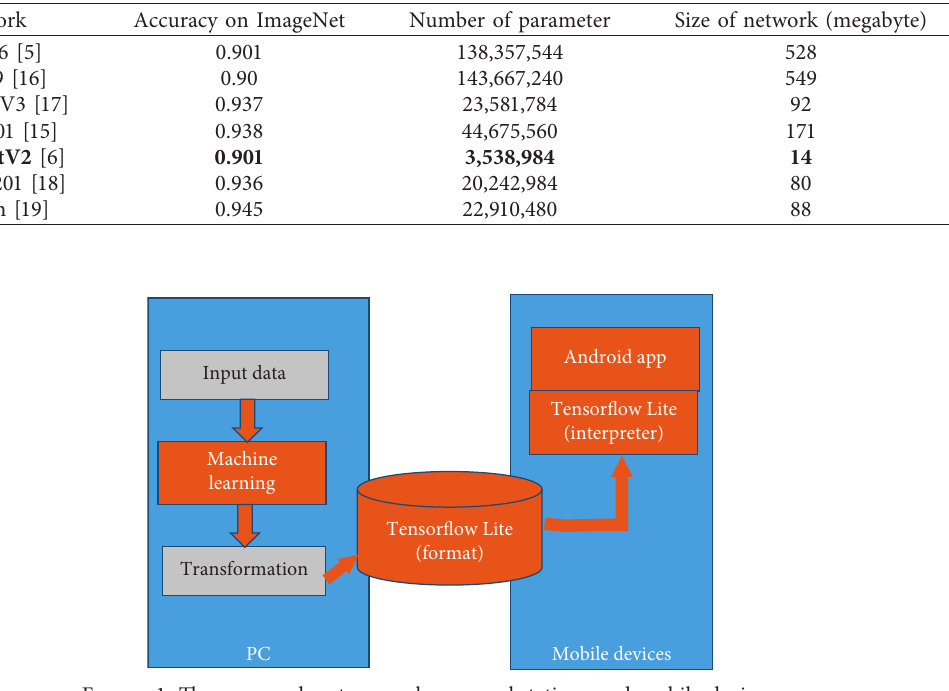
Table 1: Comparing metrics of convolution networks for ImageNet dataset.